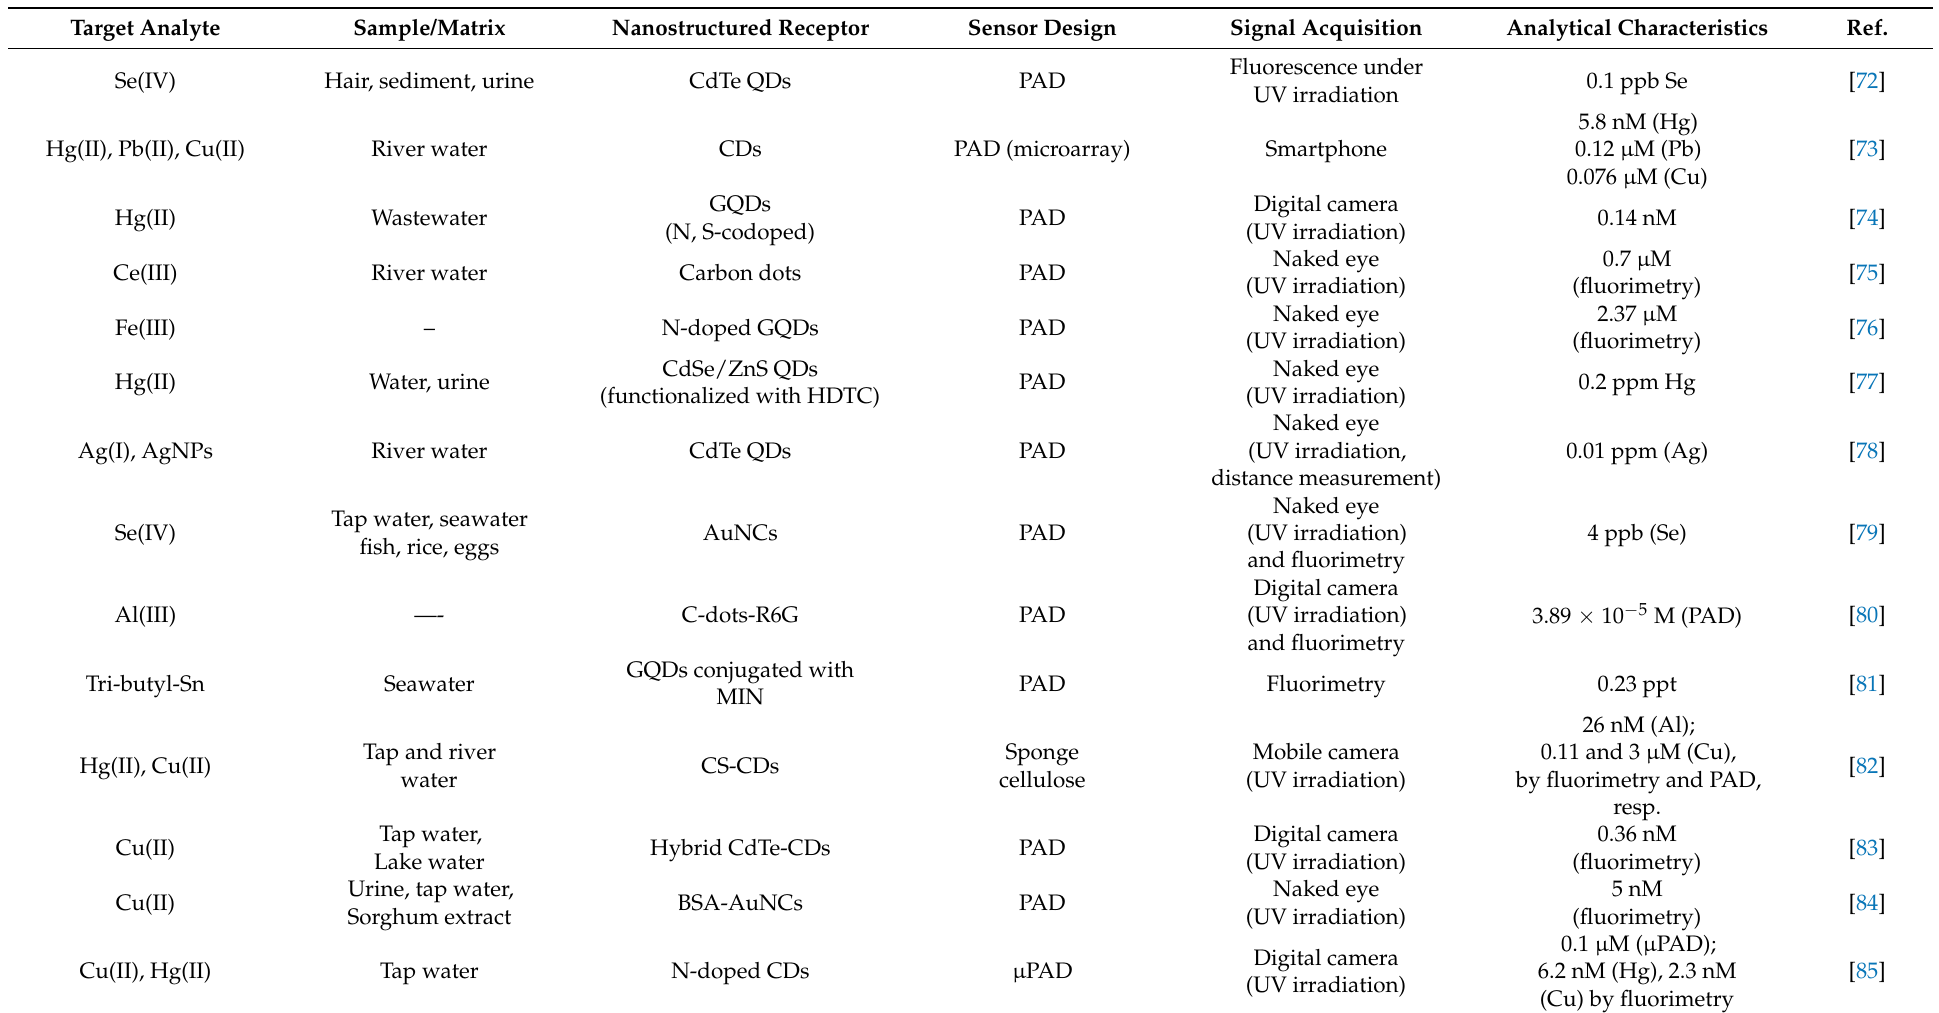
Table 2. Applications of the detection of metal ions by PADs and microPADs using luminescent nanomaterials as